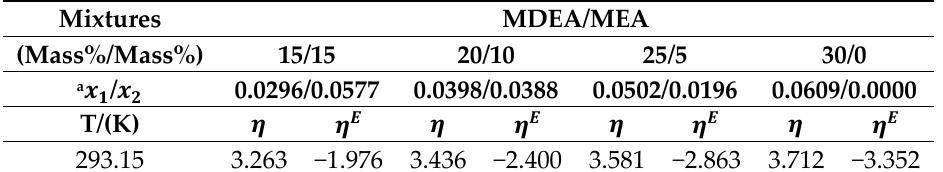
Table 11. Viscosities 𝜂 (mPa · s) and viscosity deviation 𝜂 𝐸 (mPa · s) of MDEA (1) + MEA (2) + H 2 O (3)